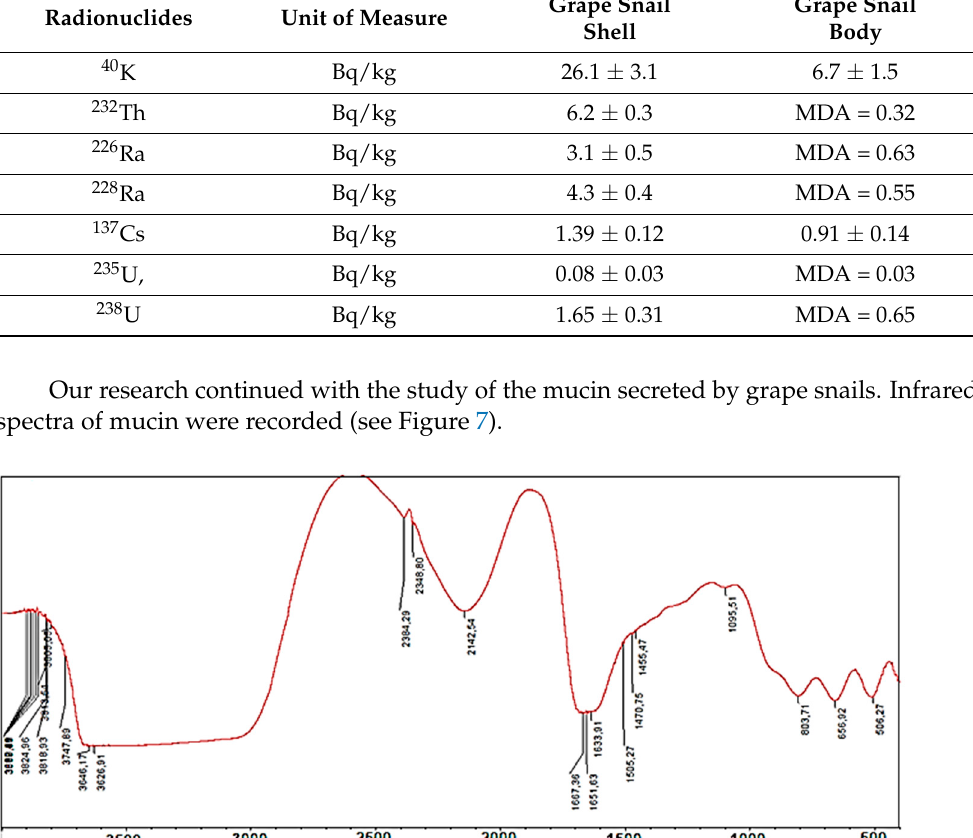
Table 1. Radionuclide compositions of shell and body parts of grape snails and their specific activities.